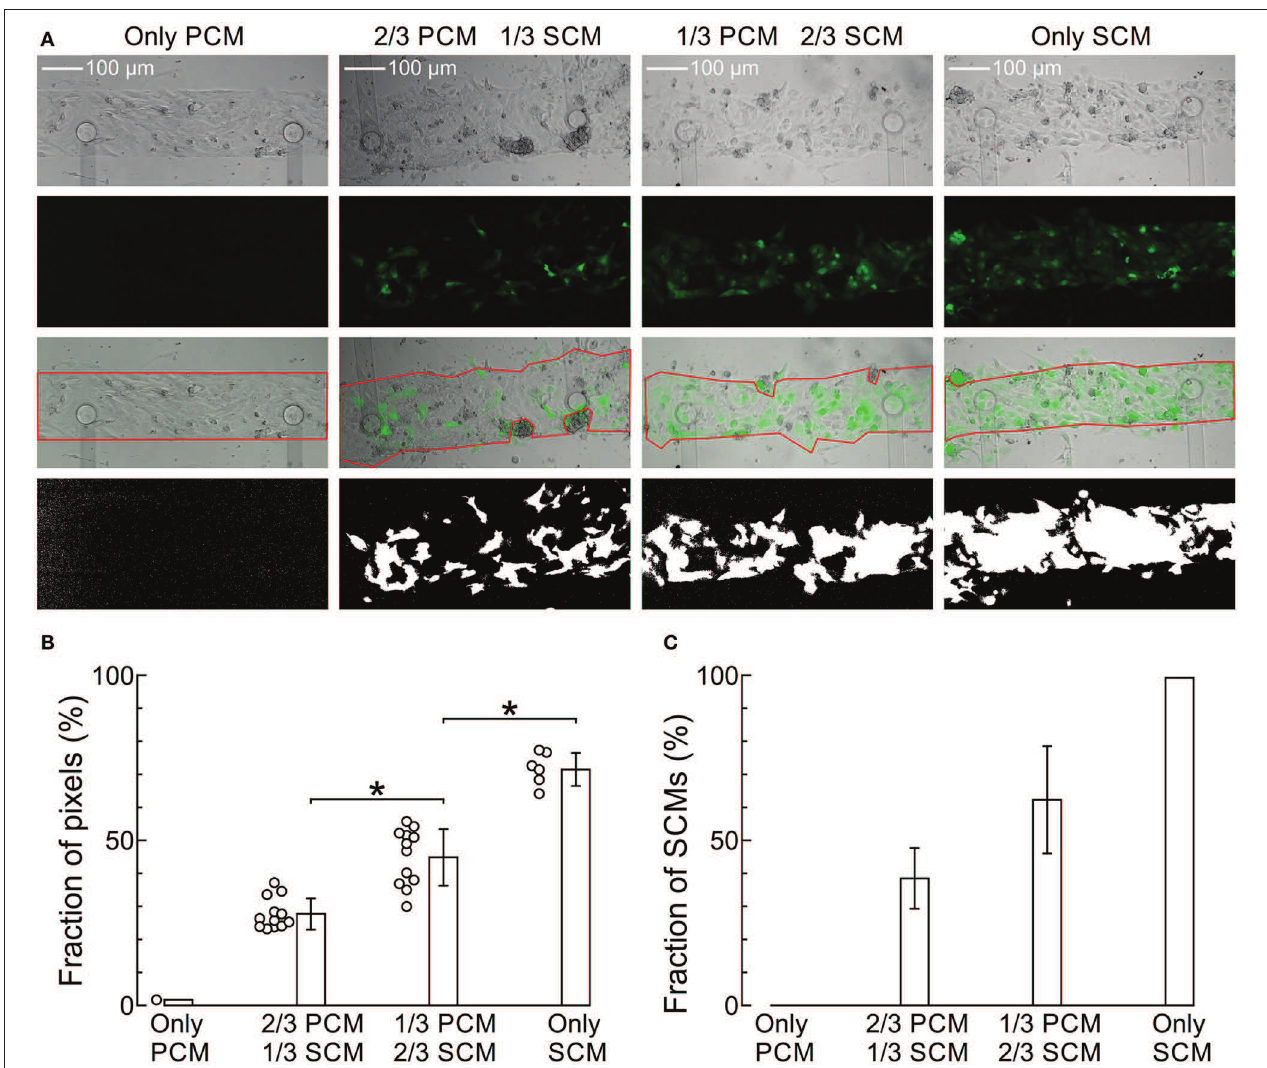
FIGURE 1 | Imaging of the cultured strands and quantification of the proportion of SCMs. (A) Phase contrast (top row), fluorescence (second row), overlay with ROI (third row) and binary fluorescence (fourth row) images of strands seeded with increasing predefined densities of GFP-tagged SCMs (labels on top). The respective proportions of white pixels in the binary images were 1.7, 23.7, 51.3, and 77.0%, respectively. (B) Analysis of white pixel proportion in all images. * p < 0.05 (ANOVA). (C) Proportion of SCMs in the four density groups after renormalization of the data in (B) and error propagation.